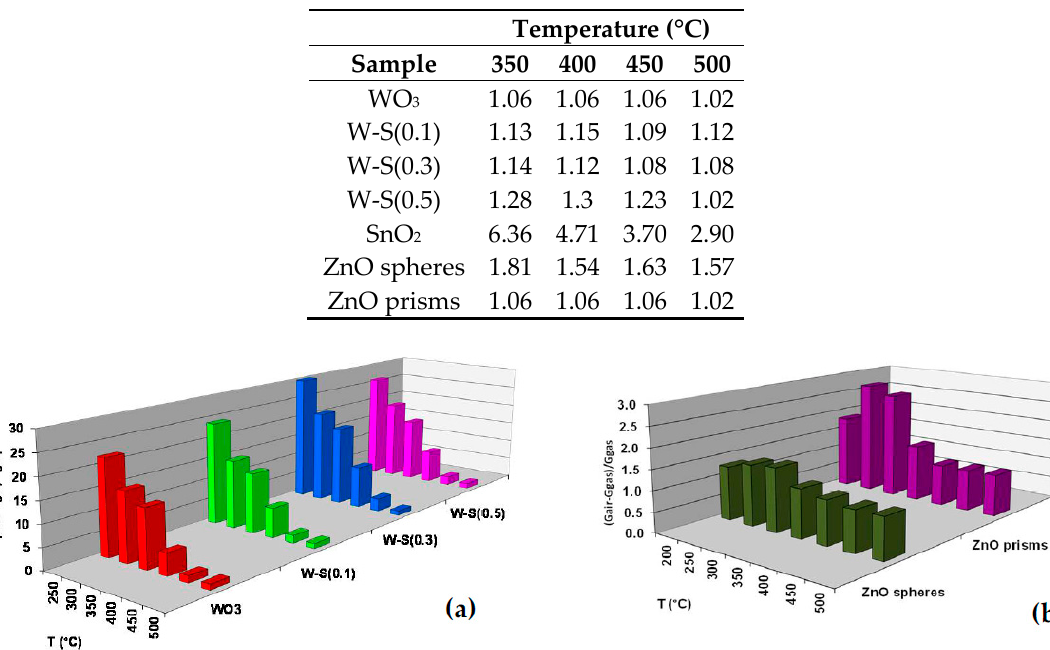
Table 1. Responses of all sensors to 50 ppm of CO reported as G gas /G air obtained at different temperatures.